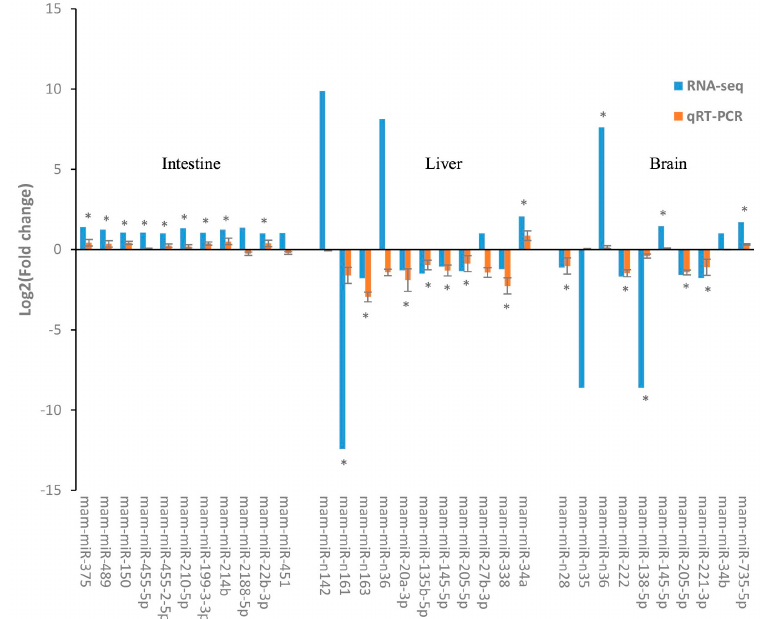
Figure 4. Quantitative real-time PCR (qPCR) analysis for 24 differentially expressed miRNAs in different tissues identified by small RNA sequencing. The stars mean that the results of RNA-seq and qRT-PCR were in consistent and all significant. The error bars were the standard deviation.